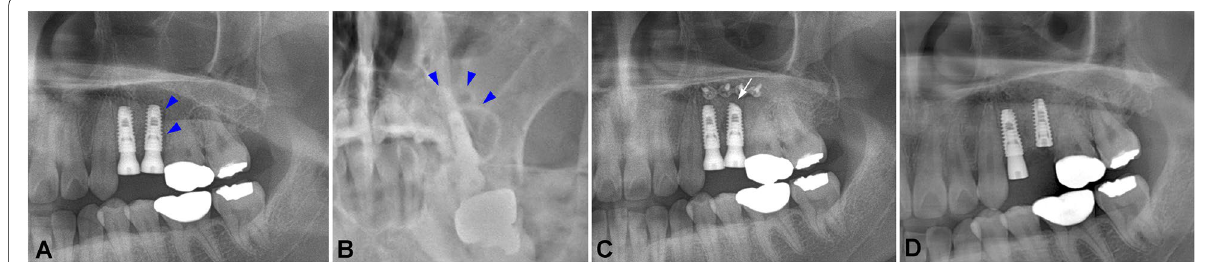
Fig. 3 Panoramic view 10 days after implant installation in case 3. There was a radiopaque area observable on the distal side of the #25i implant ( A blue arrowheads). The mucosal thickness and fluid level were made apparent using Waters’ view ( B blue arrowheads). A panoramic view taken after the patient underwent implant apex-cutting via MESS ( C white arrow). The panoramic view after #25i was removed and reinstalled. The implant demonstrated good initial contact with the bone ( D